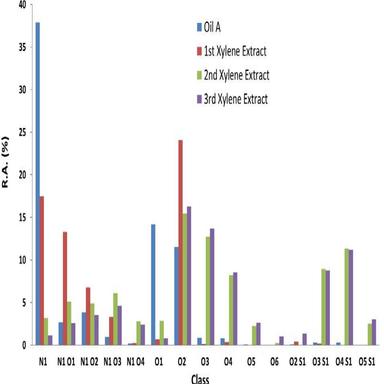
Class distribution of oil A, the 1st, 2nd and 3rd xylene extracts in (−)ESI.